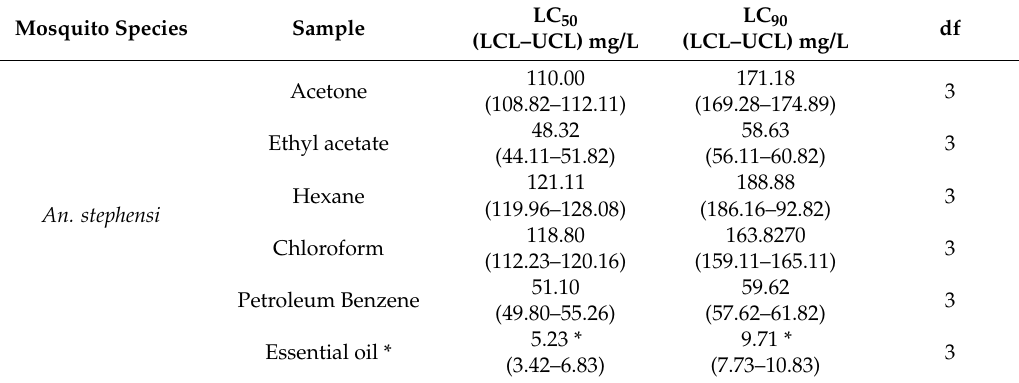
Table 1. Larvicidal activity of A. nilotica seed extracts and essential oil against the fourth instar larvae of An.